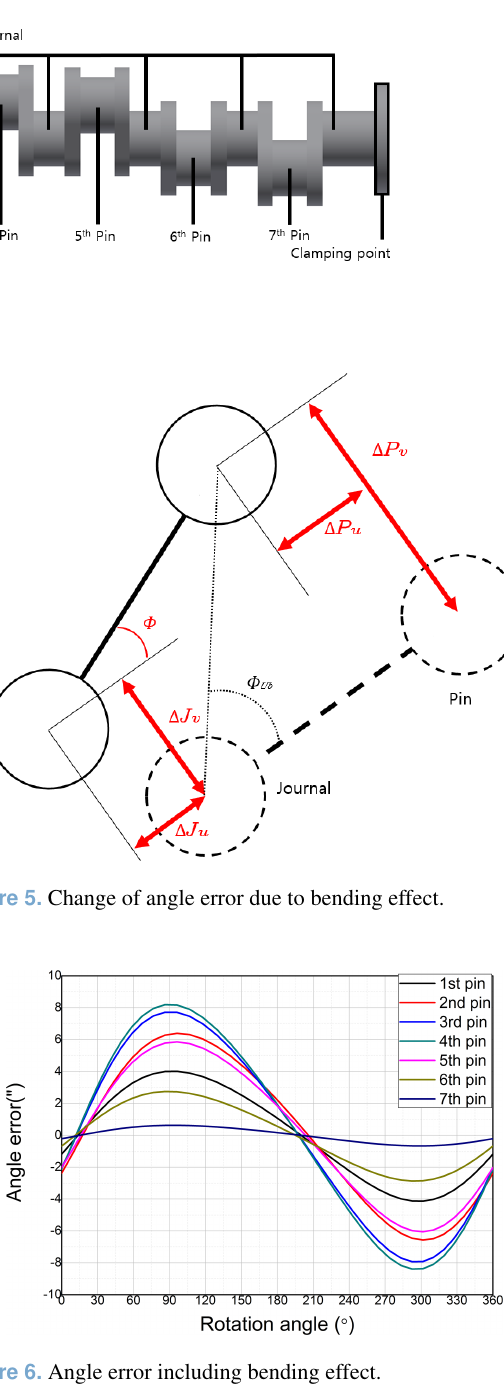
Figure 6. Angle error including bending